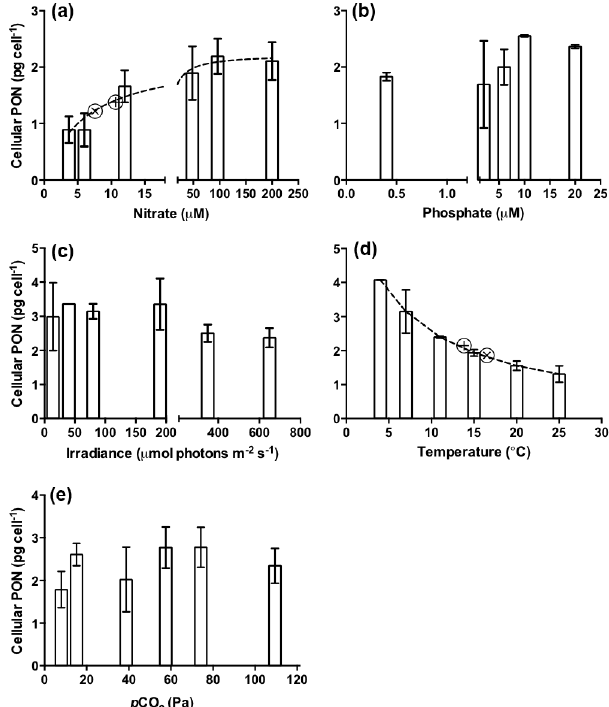
Figure 3. Changes in the ratio of Emiliania huxleyi cellular partic- ulate inorganic carbon content to particulate organic carbon con- tent (PIC:POC) in response to different environmental drivers: (a) PIC:POC ratio vs. nitrate concentration; (b) PIC:POC ra- tio vs. phosphate concentration; (c) PIC:POC ratio vs. irradiance; (d) PIC:POC ratio vs. temperature; and (e) PIC:POC ratio vs. p CO 2 .